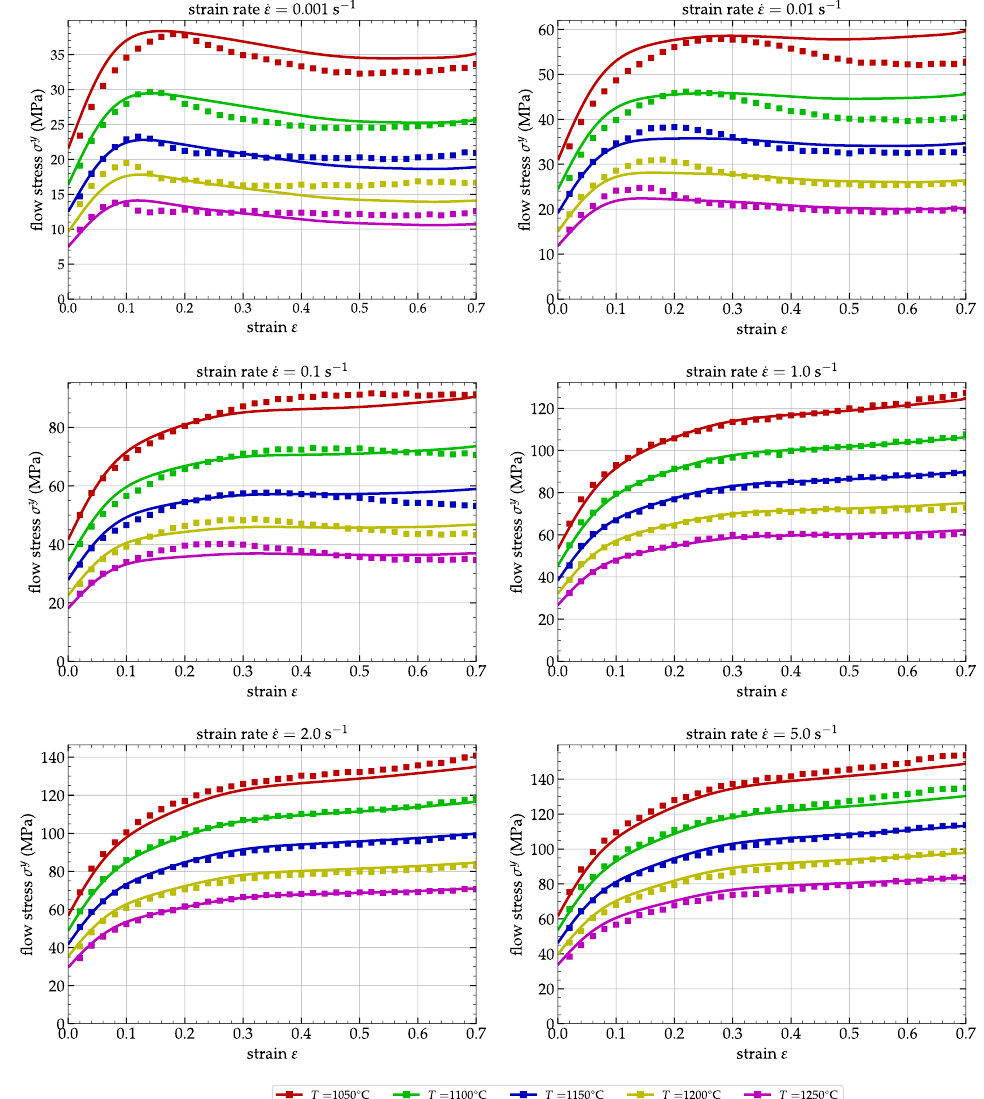
Figure 9. Comparison between the experimental (dots) and predicted (lines) flow stresses σ y by the Arrhenius model.